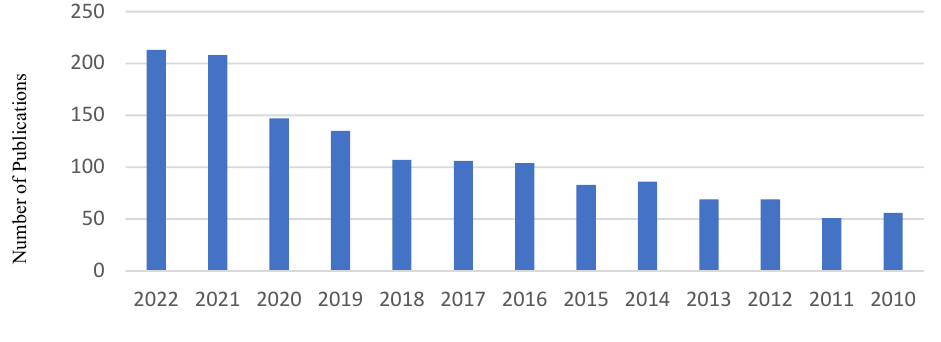
Figure 1. Number of published works every year obtained from Science Direct using the keyword: “vortex rope” (Accessed in December 2022).